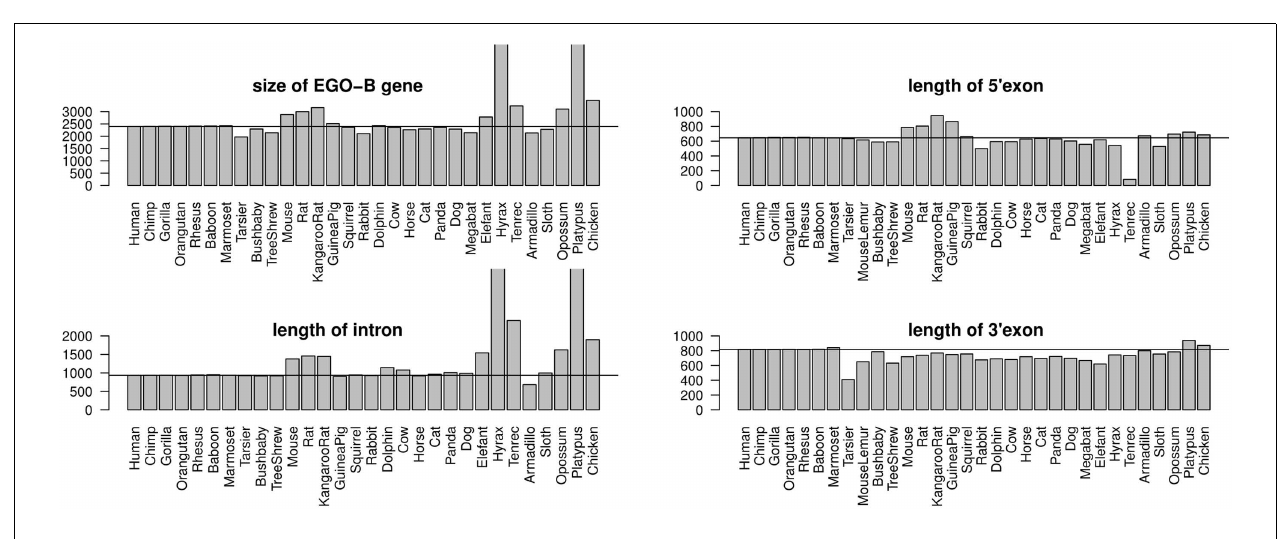
majority of species fits fairly well to the human reference. Notable exceptions are hyrax and platypus due to incomplete genome assemblies. As expected, especially rodents exhibit additional insertions compared to other higher